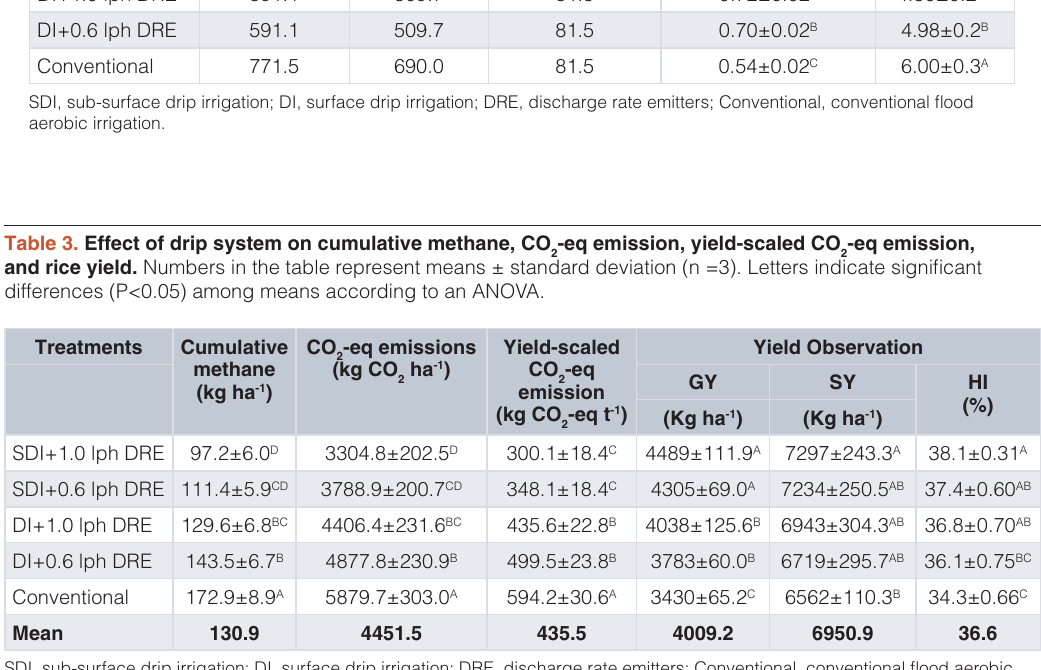
-eq emission, yield-scaled CO -eq emission, 2 2